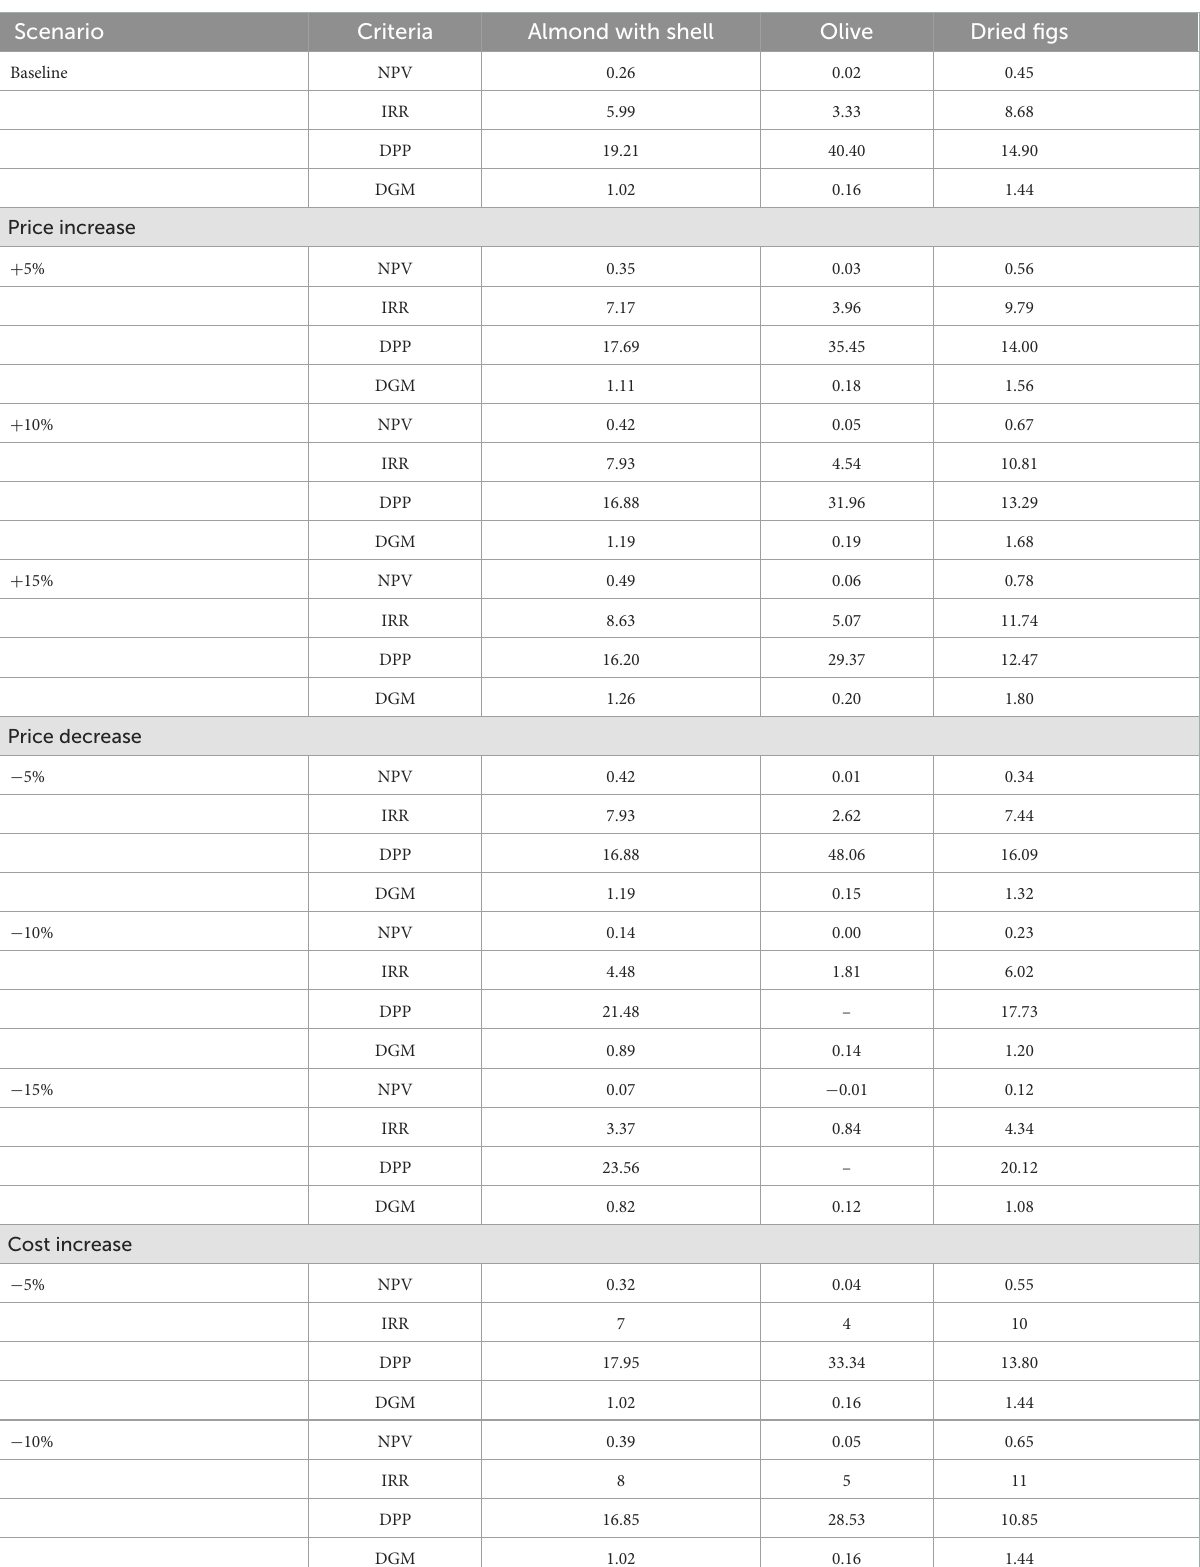
TABLE 8 Sensitivity analysis results: Part